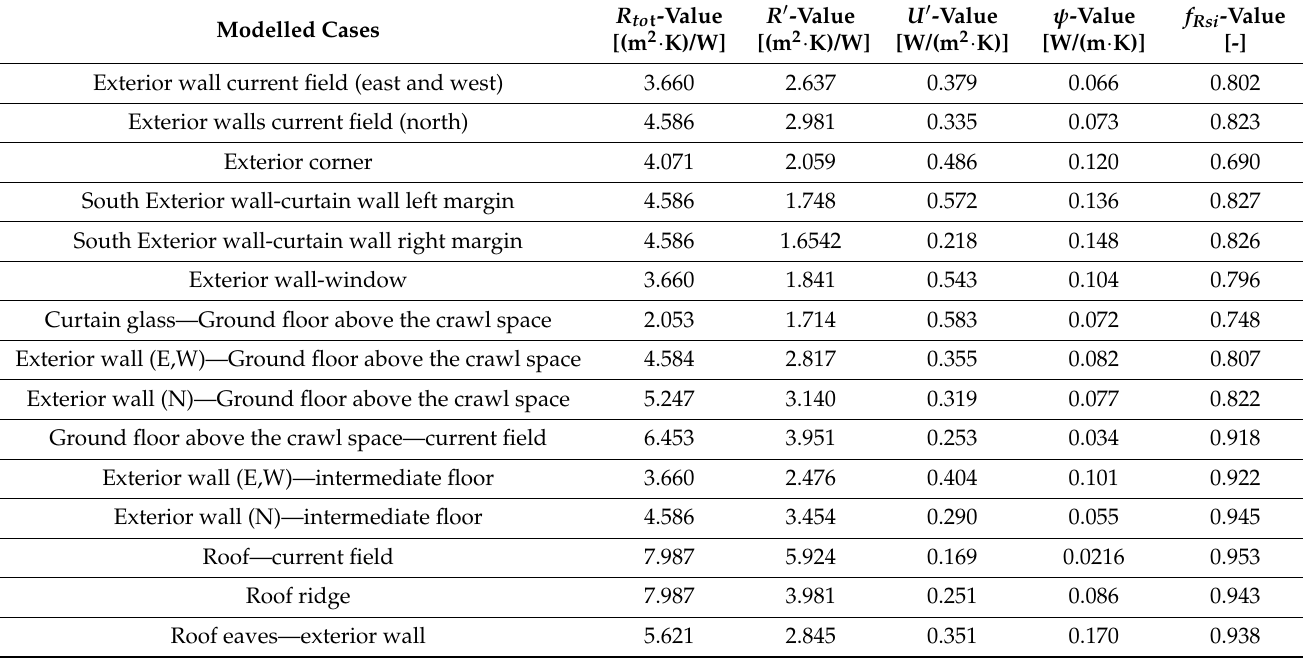
Table 3. Modelled and simulated junctions-results for the entire length of the modelled cases.